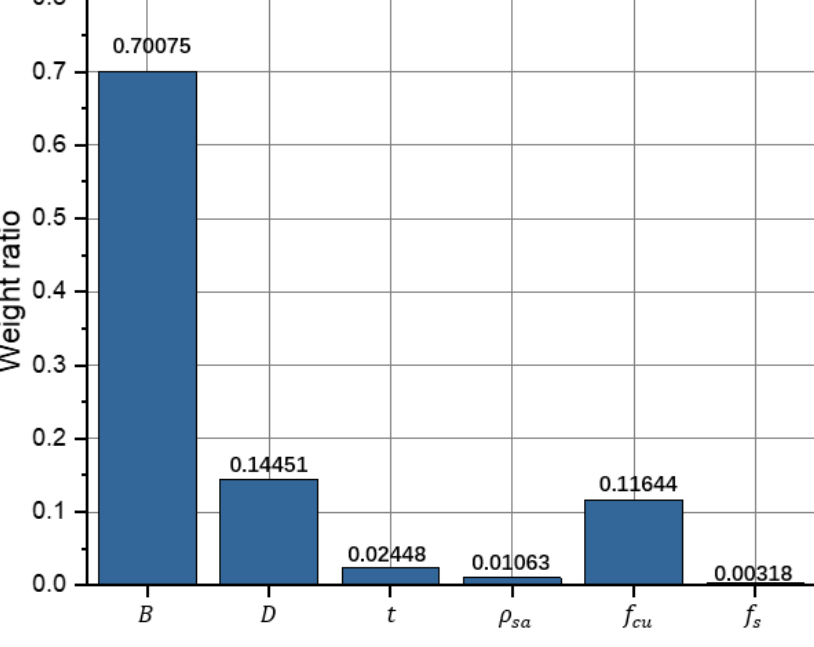
Figure 9. The weight ratio of the features. Table 4. Ultimate strengths of samples whose relative error exceeds 0.05.